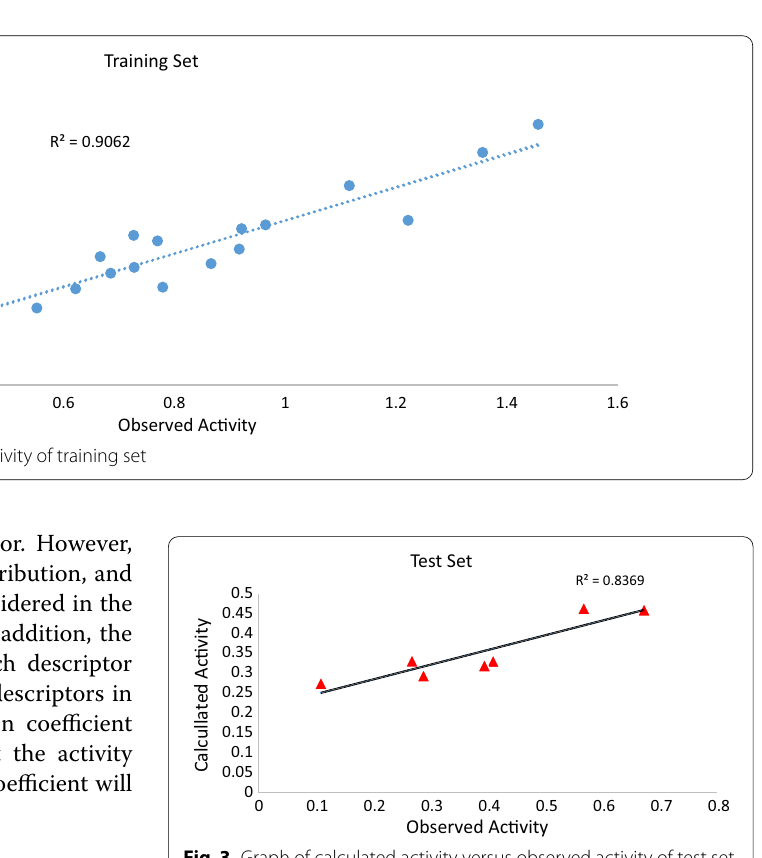
Fig. 3 Graph of calculated activity versus observed activity of test